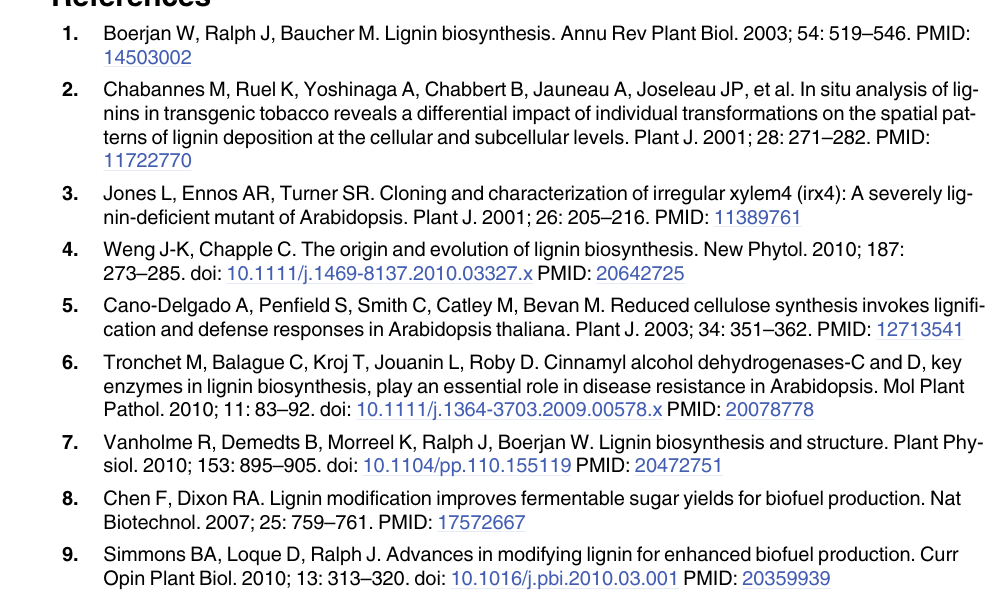
S8 Fig. Quantification of fluorescence intensities per unit area in stem sections. Quantified click labeling-associated fluorescence (561 nm excitation) and autofluorescence (405 nm exci- tation) in sections treated with 20 μ M 3-EPC, 20 μ M 3-EPC + 20 μ M CA, and 20 μ M CA and untreated sections. Data were averaged from 9 samples per treatment; error bars indicate stan- dard error. Numbers indicate statistically different data sets (P < 0.05, t-test) for 561 nm excita- tion and letters indicate statistically different data sets (P < 0.05, t-test) for 405 nm